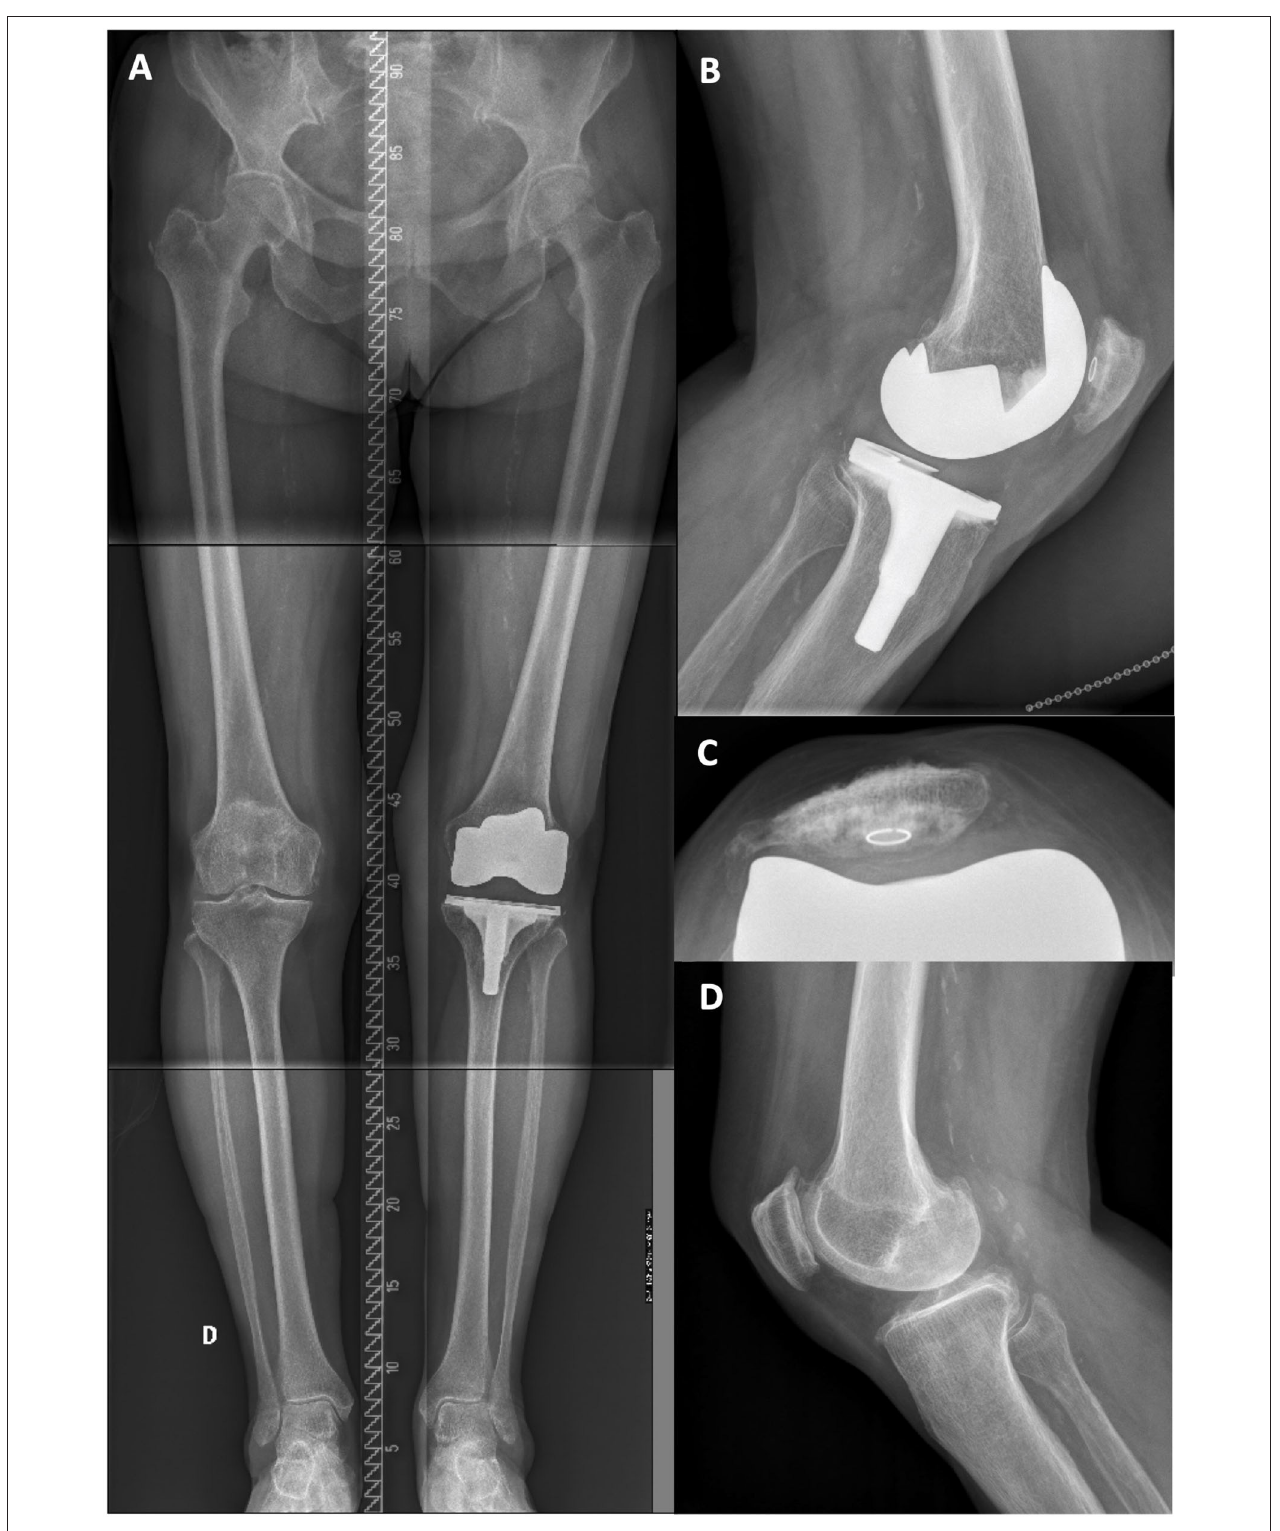
FIGURE 5 | (A) Pre-revision long leg standing X-Ray reveals a left implant mDFA of 2 ◦ varus and an mPTA of 2 ◦ valgus (0 ◦ varus aHKA). On the intact right side, the mDFA is 2.0 ◦ valgus and mPTA 3.5 ◦ varus (aHKA of 1.5 ◦ varus). (B) Left knee lateral view where the implant posterior tibial slope is 12.0 ◦ . (C) Left patella skyline view showing a lateral patellar retinaculum calcification and a well-centered resurfaced patella. (D) Right knee lateral view where the native tibial slope is 6.0 ◦ posterior.